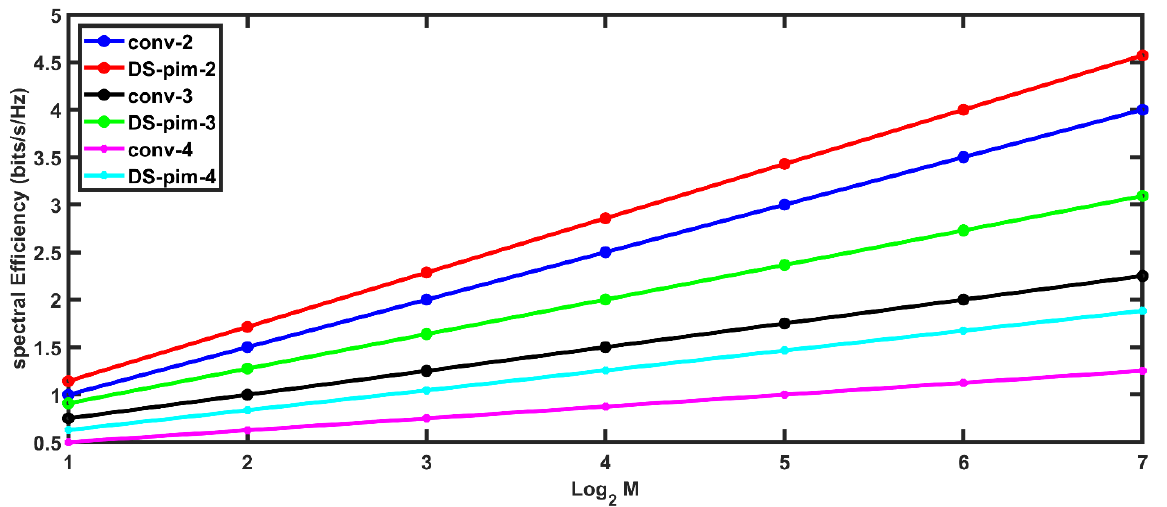
Figure 8. Spectral Efficiency versus modulation order, for conventional and DS-PIM-based SIM OFDM (index word lengths of 2-bits, 3-bits and 4-bits) where K = 2.